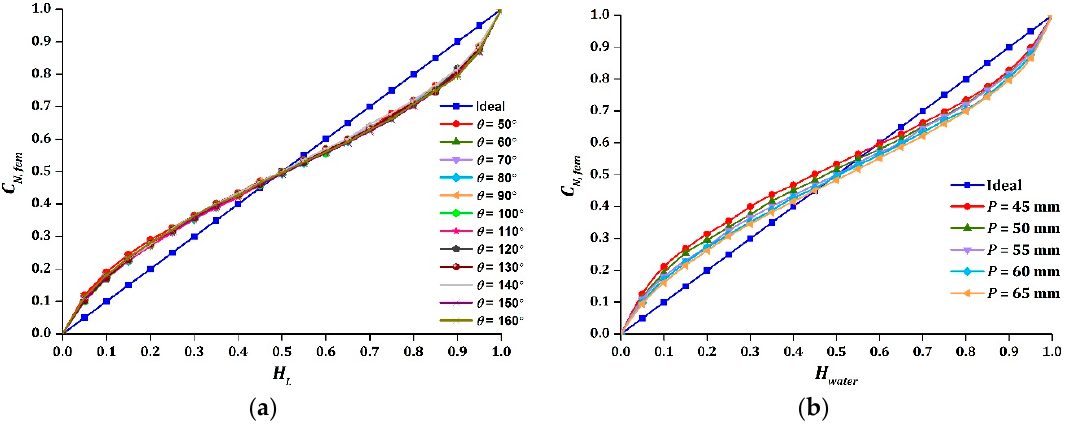
Figure 8. The effect on C N , fem due to variations of: ( a ) θ ; ( b ) P . Table 7. Absolute difference of | A 1 ´ A 2 | and the measurement span for different θ